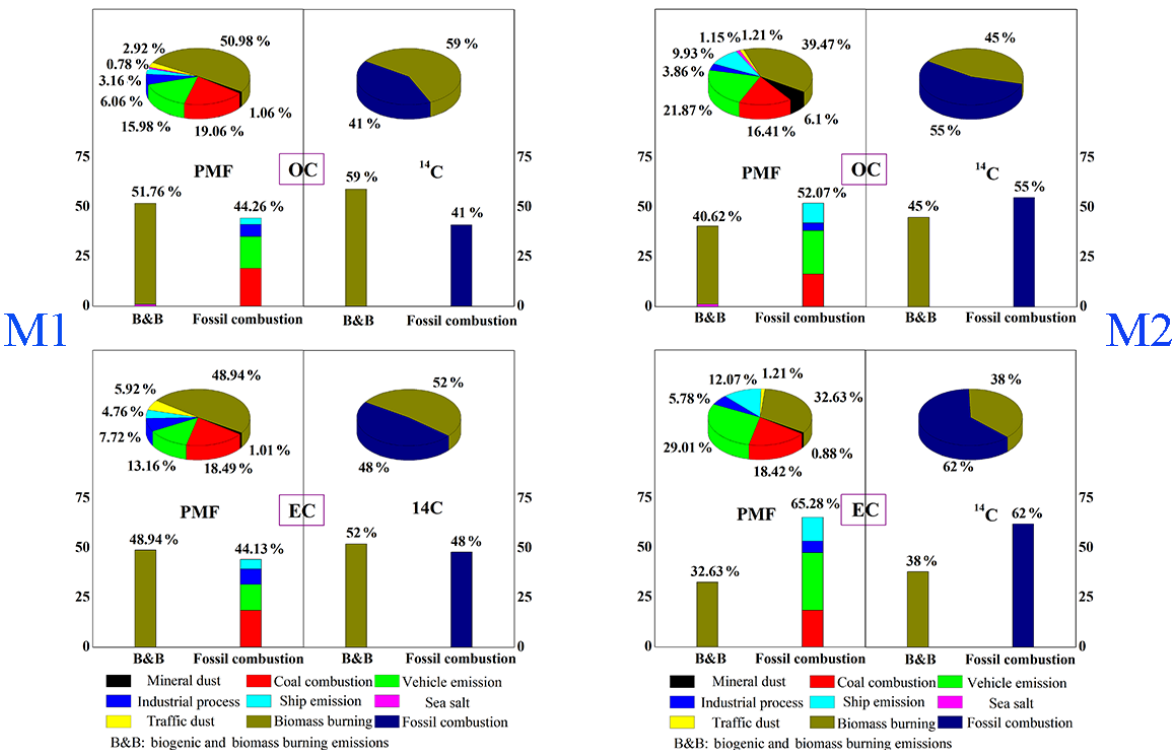
Figure 5. Comparison of source apportionment of OC and EC in the two specified samples (M1 and M2) from PMF and 14 C measurement. B&B refers to the source of biogenic and biomass burning. Note: B&B and fossil emissions from the PMF result do not add up to 100 in the bars because hybrid sources from B&B and fossil fuel combustion were not considered in the comparison (mineral dust and vehicle dust).